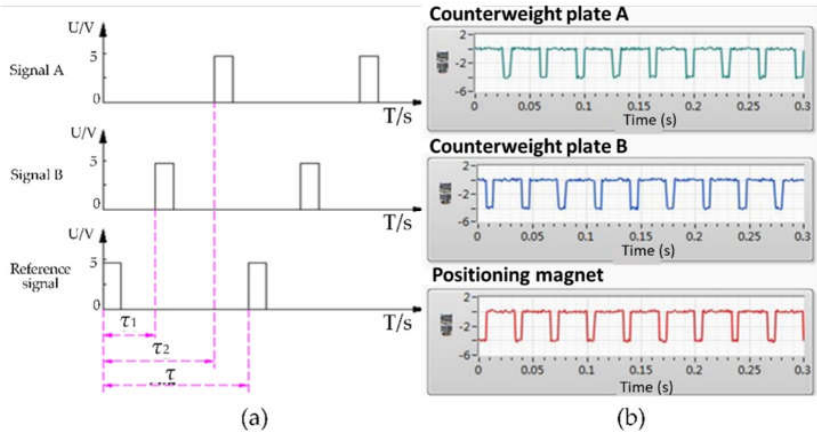
Figure 13. Three pulse signals from Hall sensors: ( a ) Schematic diagram of the signals; ( b ) Signal collection results.